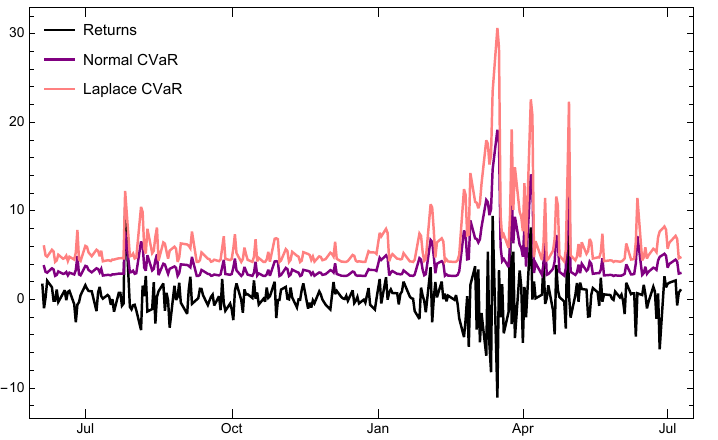
Figure 8. Computational evidence of the NASDAQ:GOOG for risk comparisons with α = 95% showing the superiority of the fatter-tailed distribution. The horizontal and vertical axes stand for the time and risk values and returns,